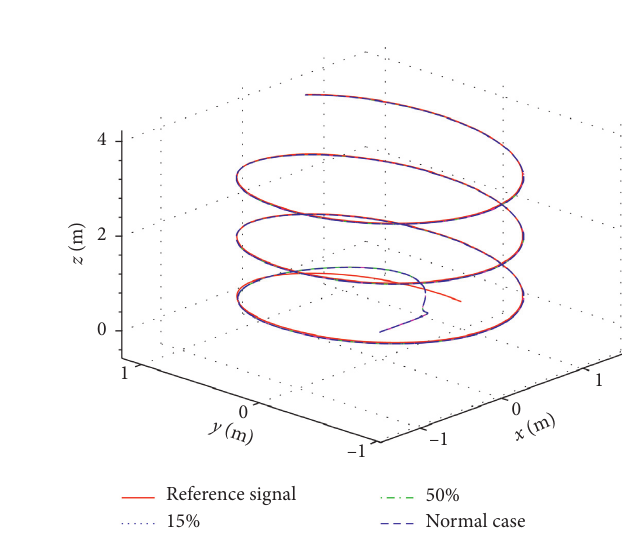
Figure 15: Actual value and estimated value.